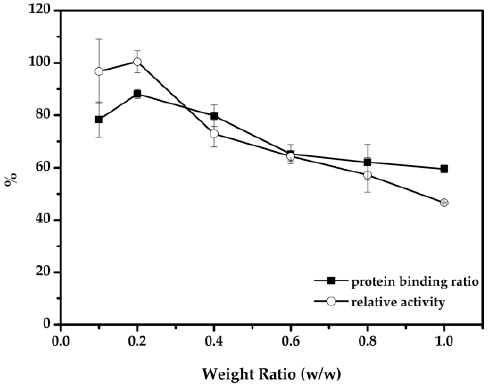
Figure 5. Effect of the weight ratio (cellulase to nanoparticles) on the activity of immobilized cellulose.